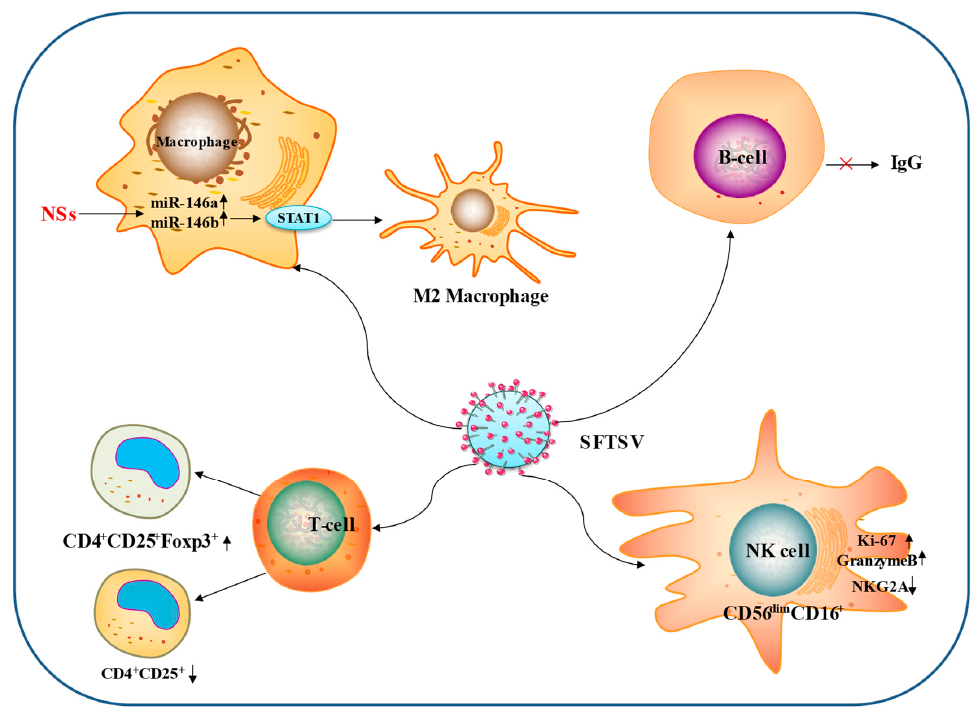
Figure 3. Interactions between SFTSV and immune cells. The main ways in which SFTSV influences the immune cells through adaptive immunity are depicted in this diagram. (1) SFTSV increased the differentiation of macrophages into M 2 cells NS-mediated endogenous miR-146b. (2) SFTSV increased the expression of Ki-67 and granzyme B in CD56 dim CD16 + NK cells. (3) SFTSV inhibits IgG antibody production by B cells. (4) SFTSV promotes CD4 + CD25 + Foxp3+ T cell production and suppresses CD4 + CD25 + T cells.